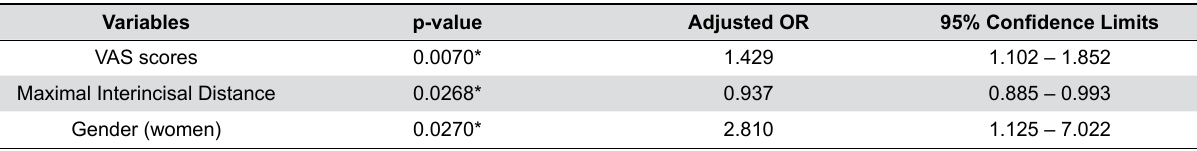
Table 3- Multivariate analysis - Adjusted odd ratios (OR)